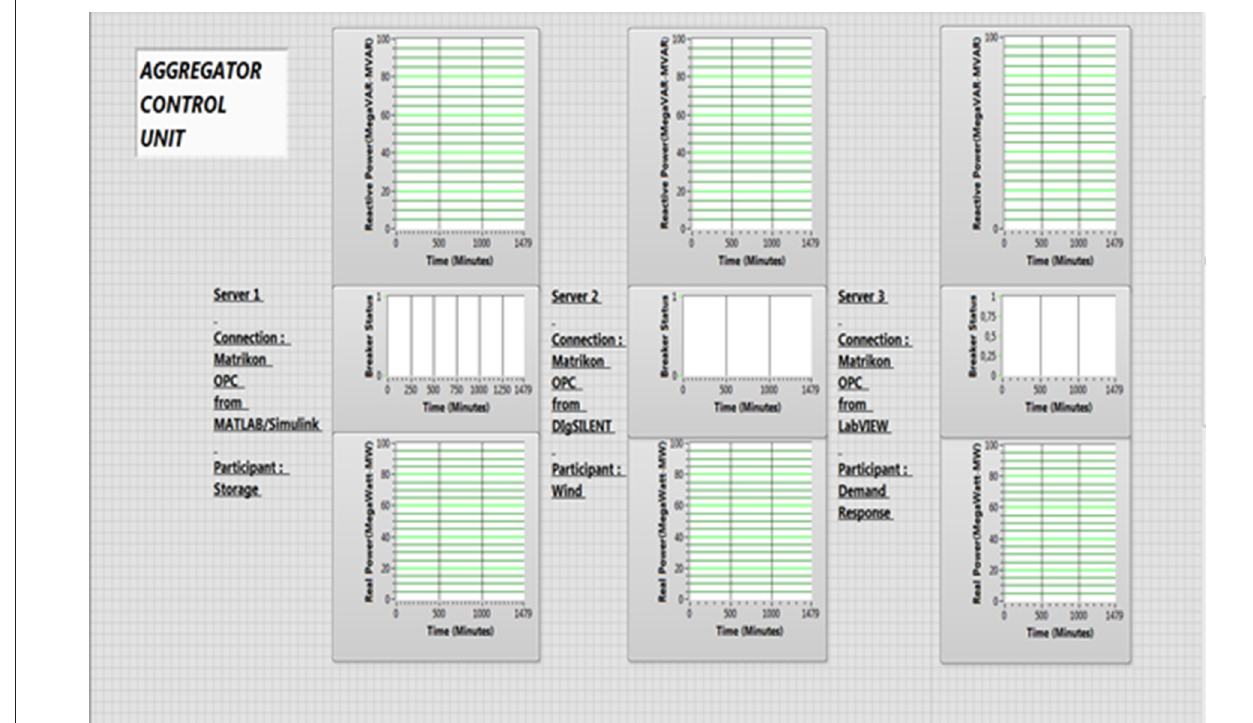
FIGURE 7 | J-DSO platform.